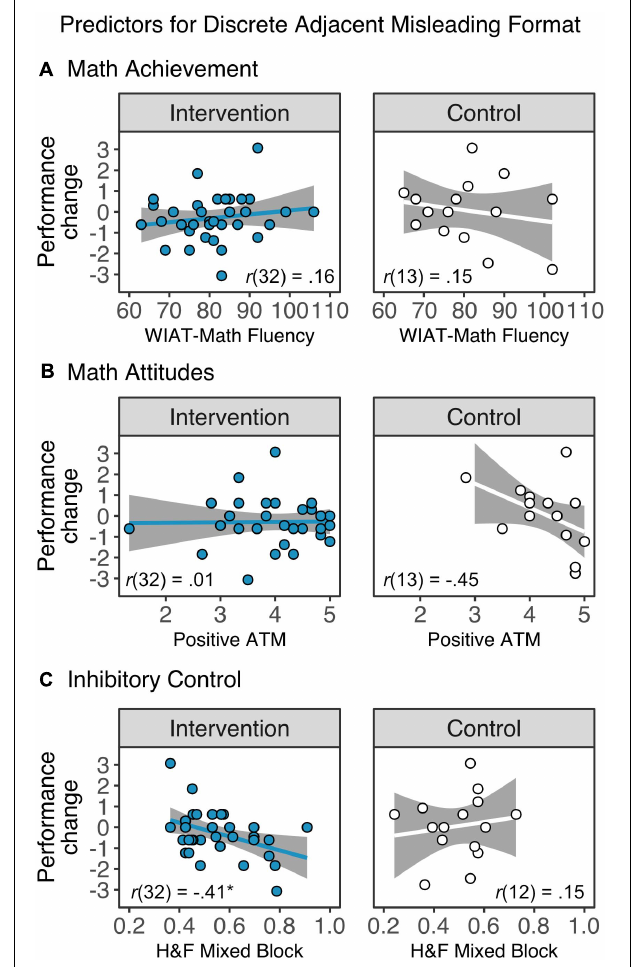
FIGURE 6 | Associations between changes in performance in the continuous format of the Spinners task and (A) math achievement, as measured by the fluency subtests from the Wechsler Individual Achievement Test (WIAT)-III, (B) attitudes toward math (ATM), and (C) inhibitory control, as measured by the mixed block of the Hearts and Flowers (H&F) task. Children in the intervention group with better math skills and more positive attitudes toward math showed marginally larger learning gains. In contrast, children with lower inhibitory control skills in this group showed marginal larger gains. Notably, none of the correlations with change scores in the control group reached significance. * p corr < 0.05, † p corr < 0.10.